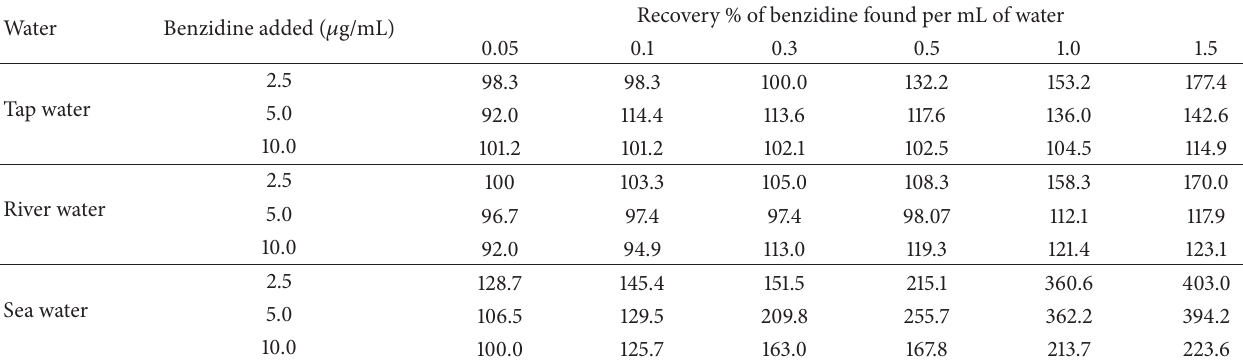
Table 7: Determination of benzidine in different waters.